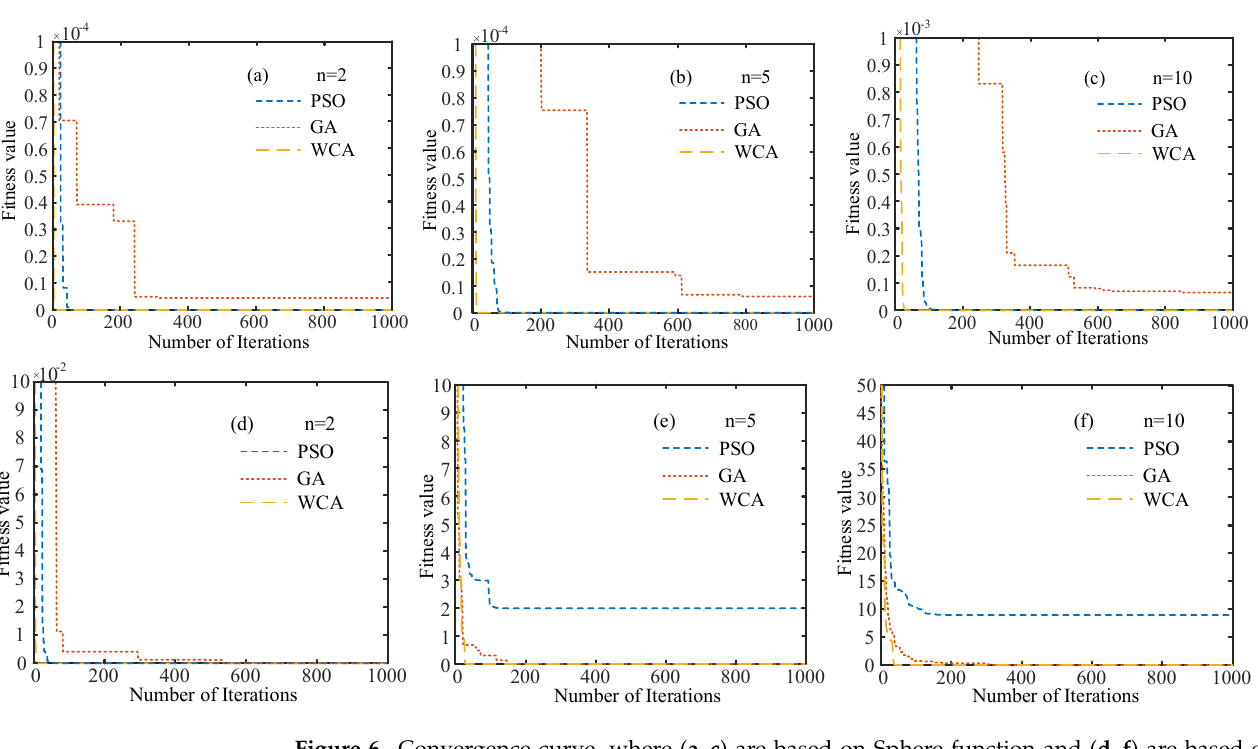
Rastrigin function.